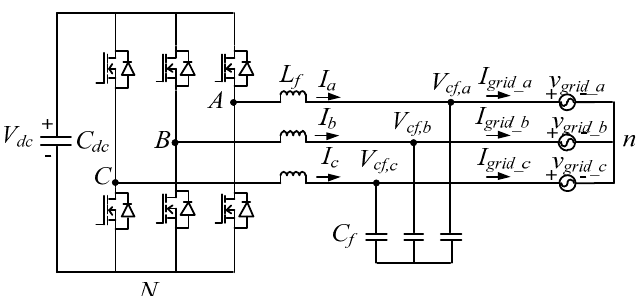
Figure 1. The test system architecture consisting of a grid, a load, and a GaN HEMTs-based three- phase STATCOM.